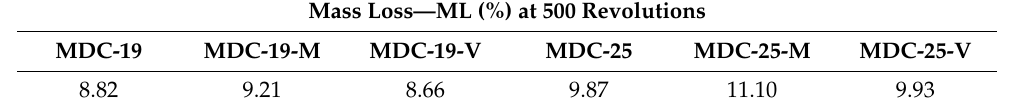
Table 6. Cantabro test